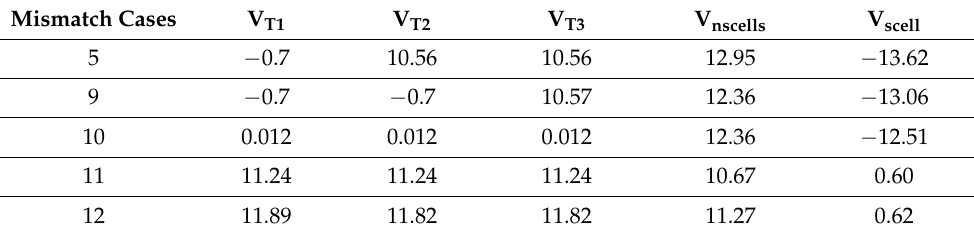
Table 3. Voltage across shaded PV sub-modules and PV cell(s) equipped with bypass diode.